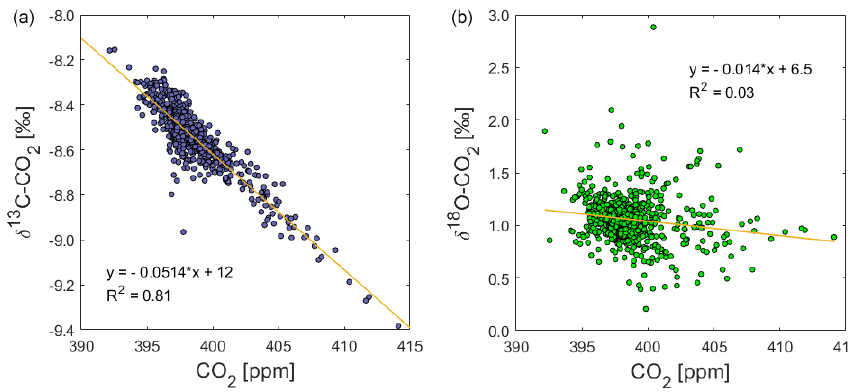
Figure 13. Correlation between CO 2 and δ 13 C-CO 2 (a) and δ 18 O-CO 2 (b) in air ( n = 791).